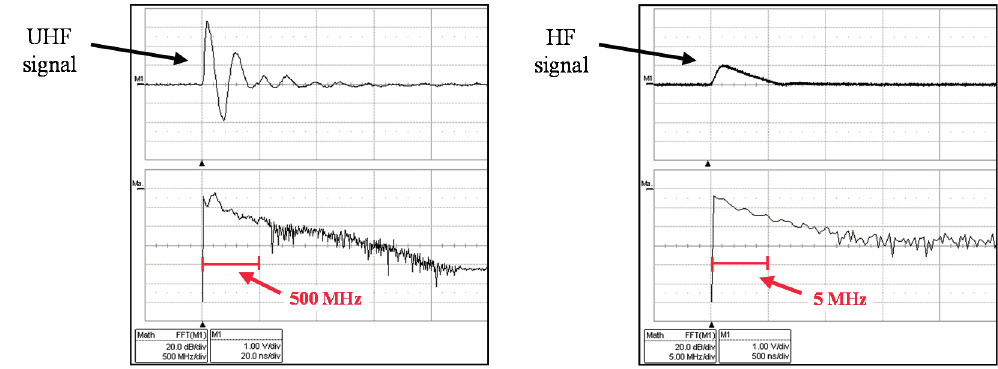
Figure 10. Frequency analysis of an original UHF pulse and the transformed